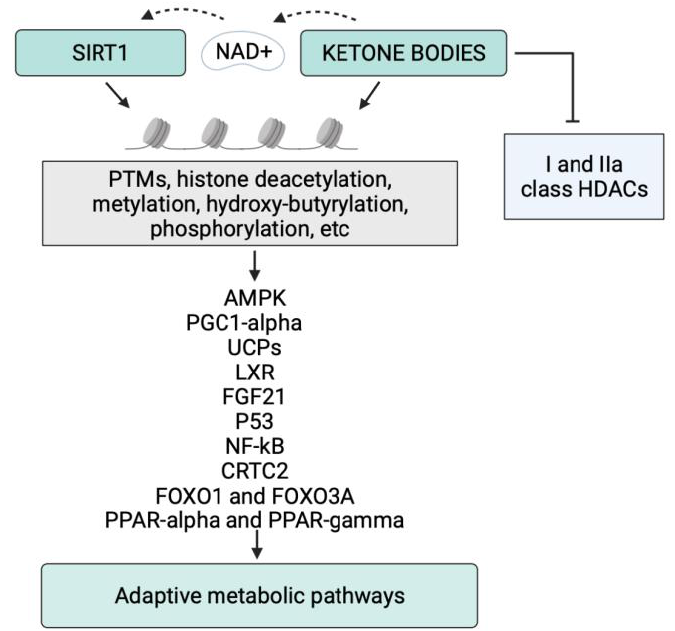
Figure 2. Schematic representation of the epigenetic control of KBs and SIRT1 on their targets. Post-translational modifications (PTMs) are key mechanisms for epigenetic regulation, which alters the activity of metabolic modulators. Abbreviations: NAD, nicotinamide adenine dinucleotide; AMPK, AMP-activated protein kinase; PPAR-alpha, peroxisome proliferator-activated receptor- α ; PPAR-gamma, peroxisome proliferator-activated receptor- γ ; PGC1- α , PPAR γ -coactivator1- α ; FOXO, Forkhead Box O; CRTC2, cAMP response element-binding (CREB)-regulated transcription coactivator 2; UCPs, uncoupling proteins; LXR, liver X receptor; FGF-21, fibroblast growth factor- 21.